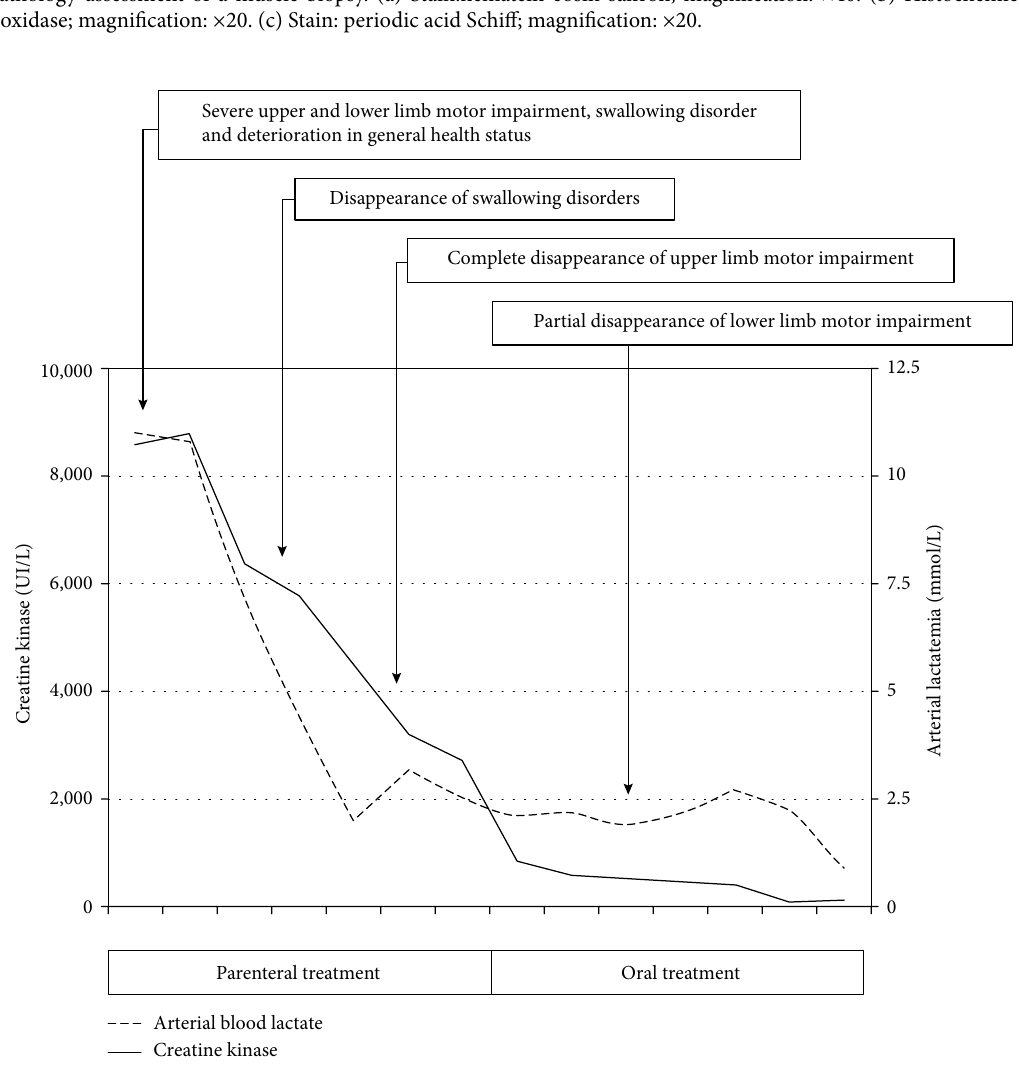
Figure 3: Changes in clinical and laboratory parameters during